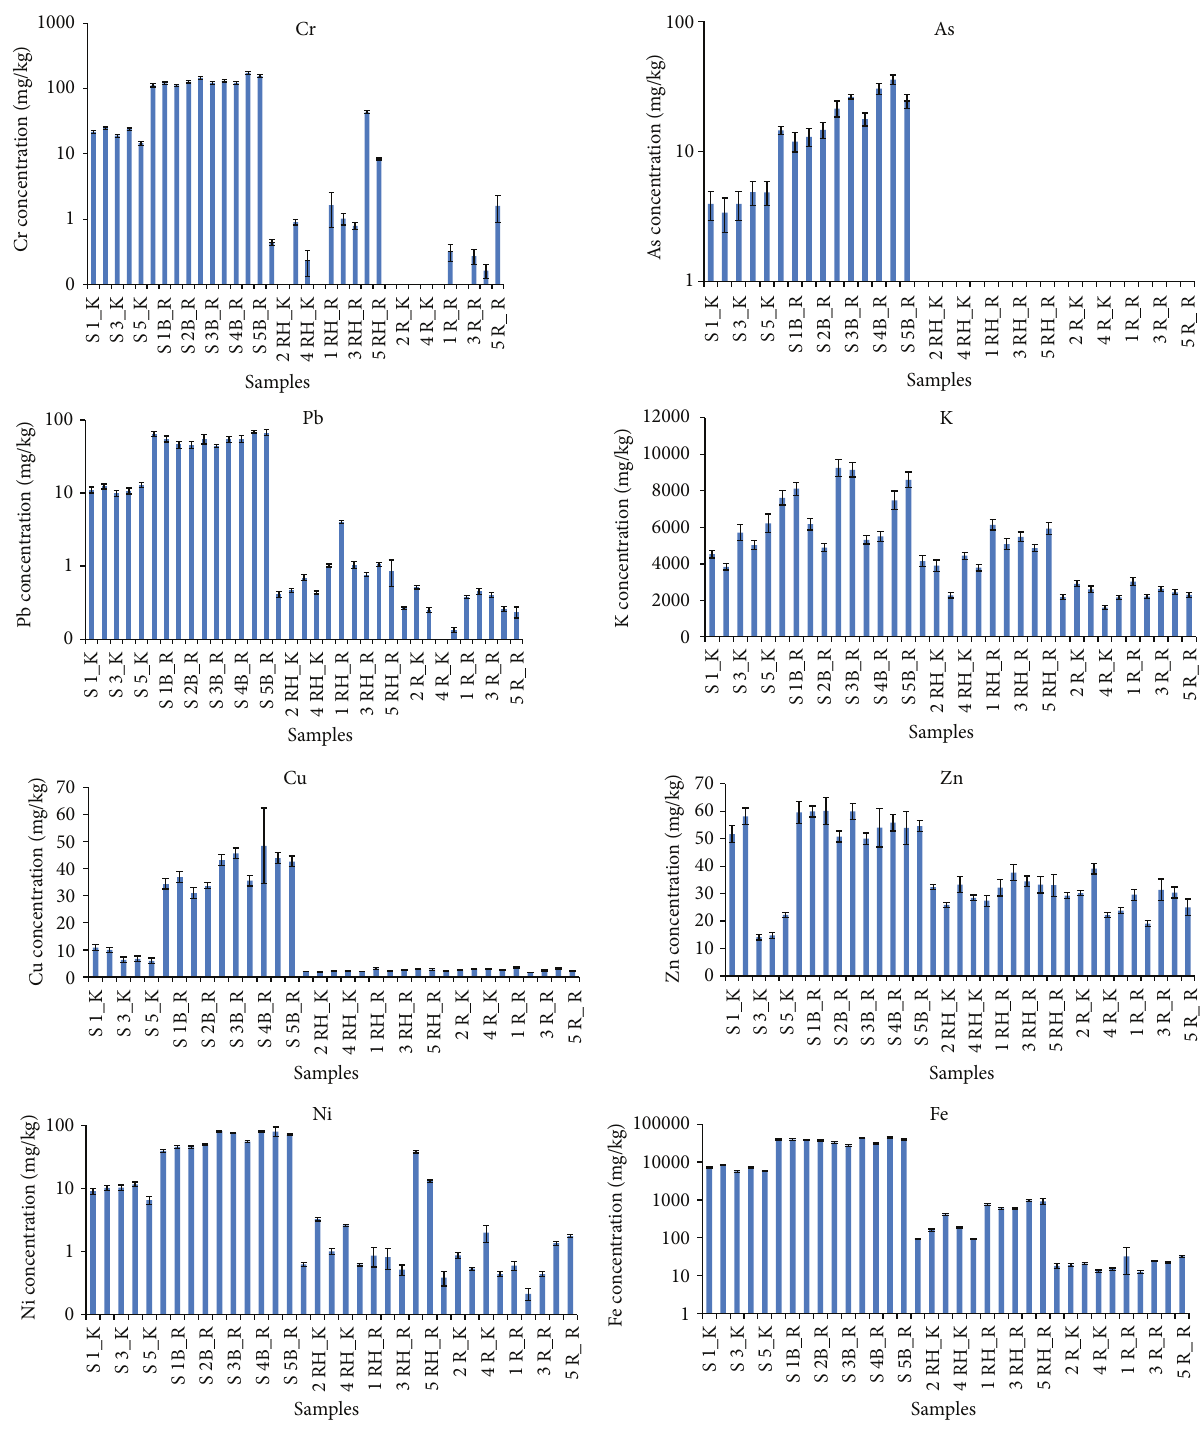
Figure 5: Concentration of elements in soil, rice husk, and rice samples from Korba and